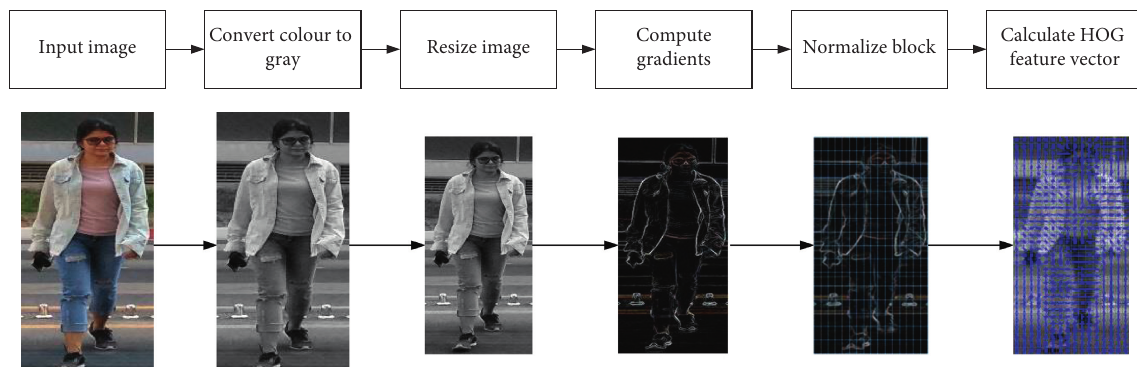
Figure 3: Process of feature extraction with the histogram of oriented gradients (HOG).